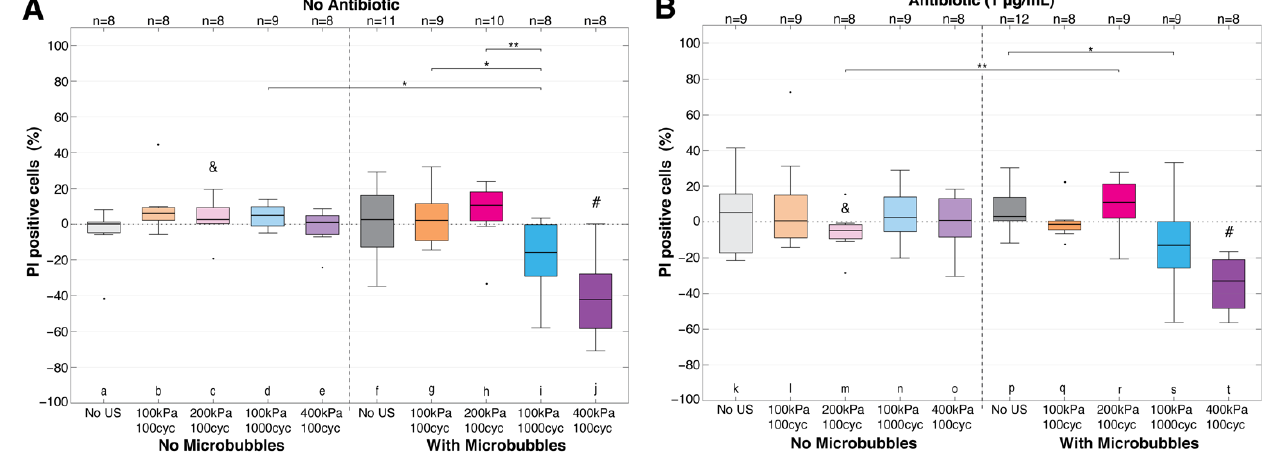
Figure 5. Sonoporation considering change in propidium iodide-positive cells only (Equation (1); PI change (%)). Key statistically significant differences are indicated above the box plots with * p < 0.05 or ** p < 0.01. Statistical significance from all other groups within the same graph are marked by a (#). If adding an antibiotic, ( B ) was different from the same treatment without ( A ), this is denoted with (&) for p < 0.05. Black circles denote outliers. cyc = cycles; PI = propidium iodide; US = ultrasound. See Supplementary Table S2 for all statistical comparisons .